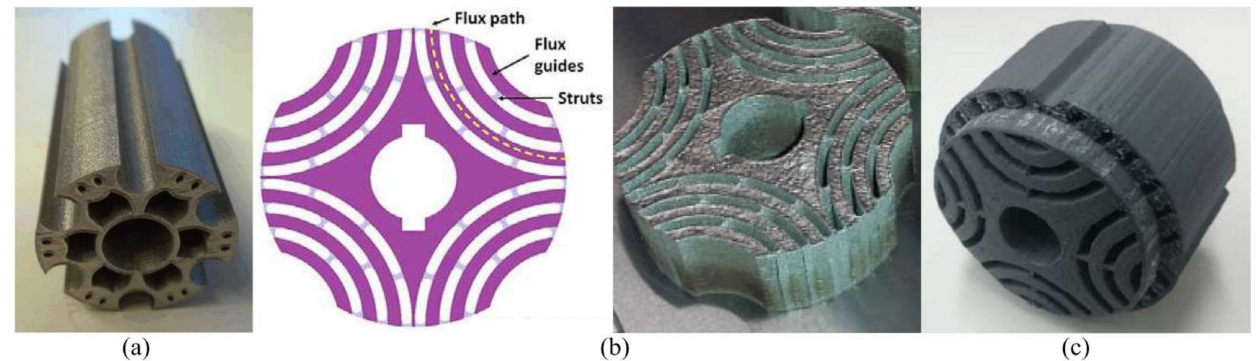
Figure 7. Additively manufactured cores for electrical machines: ( a ) Rotor prototype for an SRM with high-saturation flux density [26], ( b ) SLM-built flux barrier rotor with non-magnetic bridges [27], ( c ) Rotor and stator core packs for a line-start synchronous reluctance machine